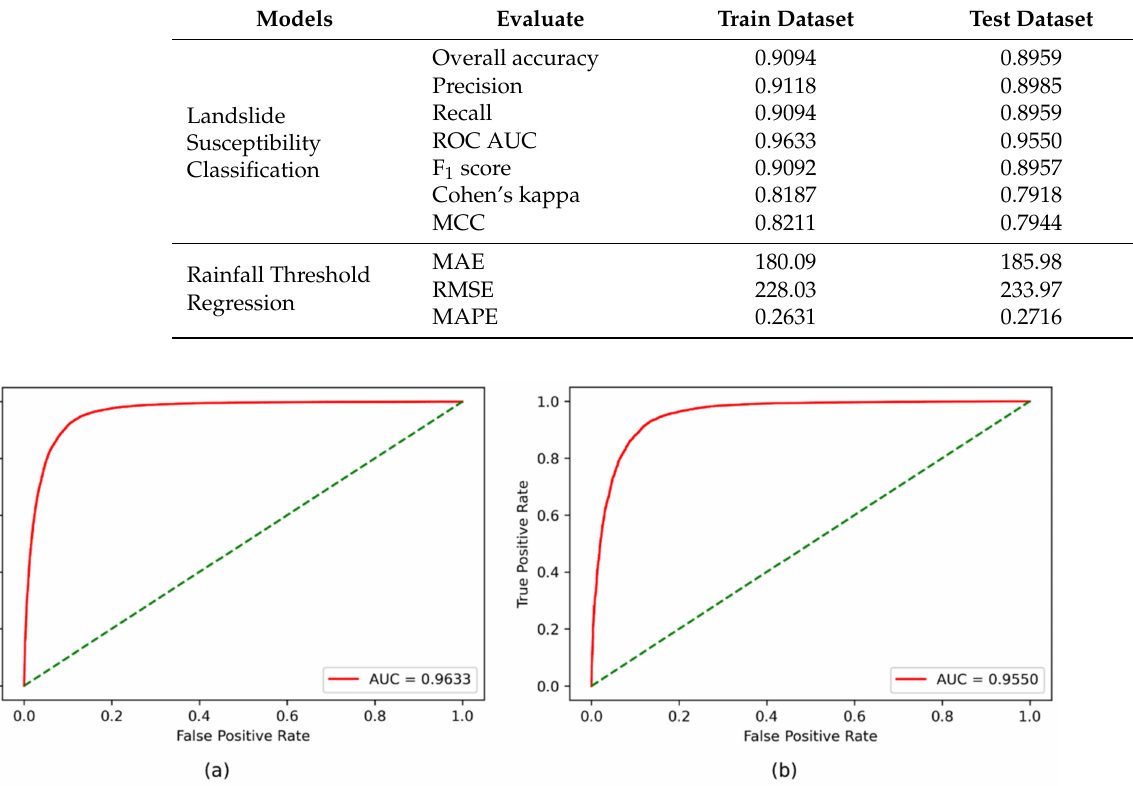
Figure 9. The ROC area under curve. ( a ) Training dataset; ( b ) test